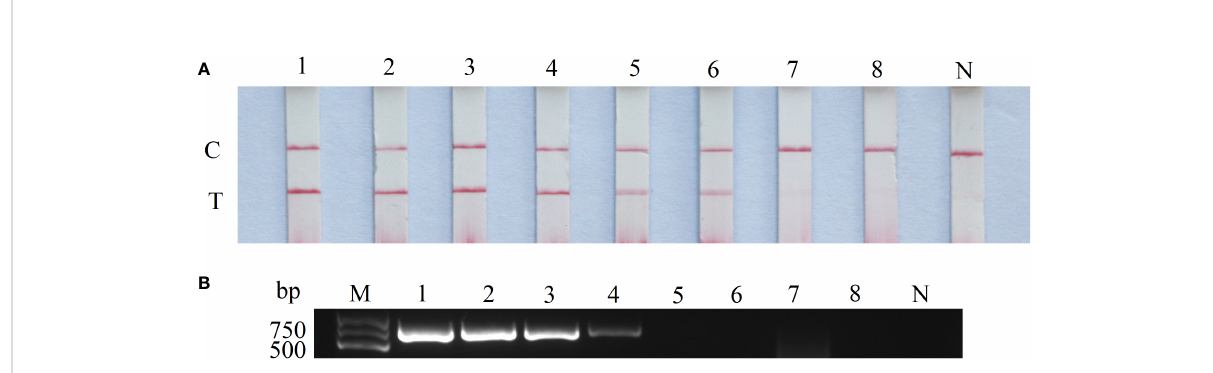
FIGURE 4 Sensitivity of RAA-LFD and PCR-AGE assays. (A) RAA-LFD; (B) PCR-AGE; 1-8: 10 7 copies/ m L~10 0 copies/ m L. N, Negative control; C, control line; T, test line; M, DNA Marker (100~2000